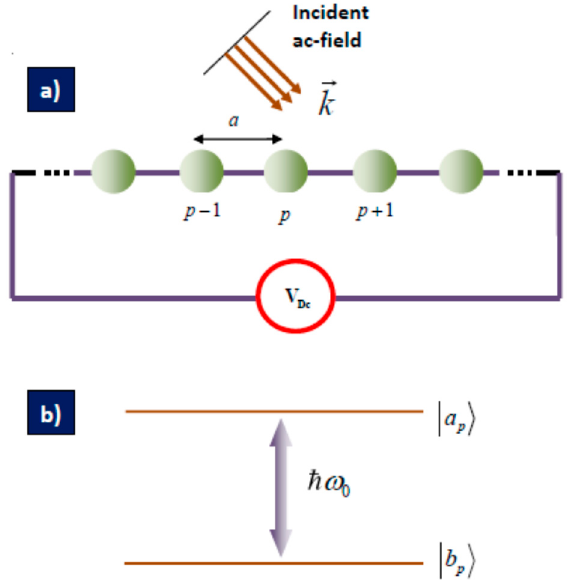
Figure 1. ( a ) General illustration of the periodic two-level atomic chain used as a model, indicating Rabi–Bloch oscillations (RBO) in strong coupling regime. It is excited with obliquely incident ac field, and driven with dc voltage applied at the ends. The neighboring atoms are coupled via interatomic tunneling, with different values of penetration at the ground and excited states; ( b ) Ground and excited energy levels of single two-level atom separated by the transition energy (cid:125) ω 0